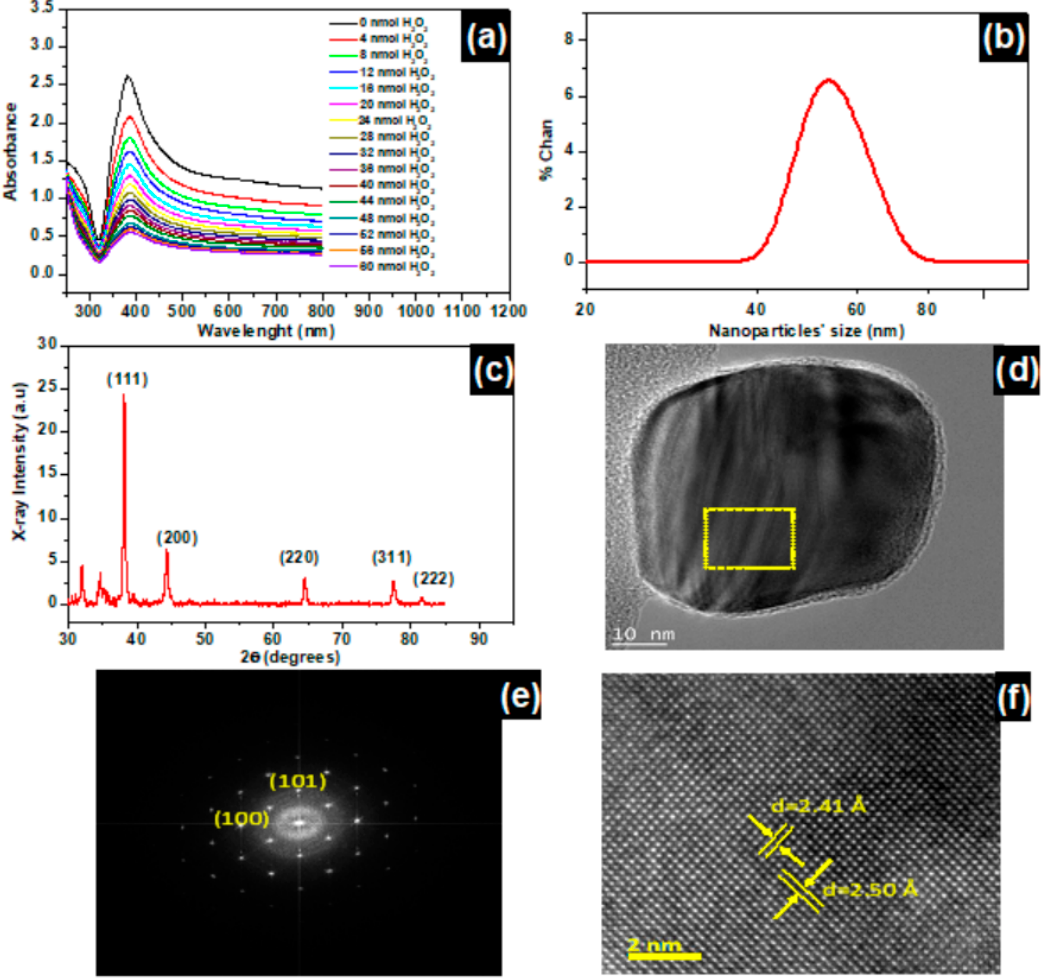
β CD-AgNPs. ( d ) HRTEM micrograph of a typical 50 nm β CD-AgNPs with 2.4 nm of β CD macromolecule coating